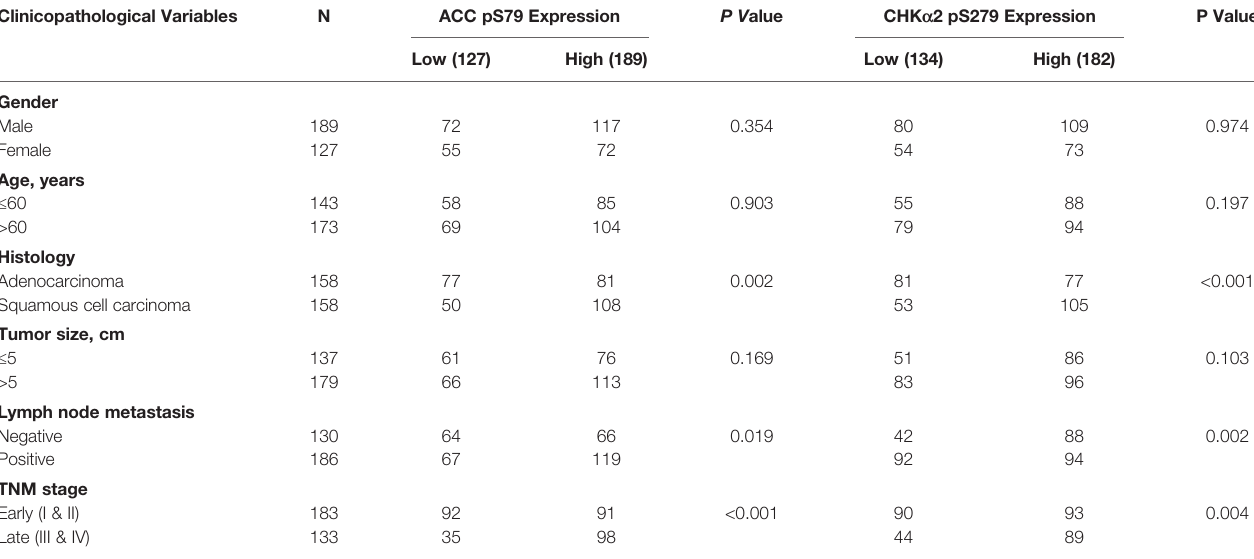
TABLE 2 | Correlation analyses of ACC pS79 and CHK a 2 pS279 expressions with clinic-pathological characteristics. Clinicopathological Variables